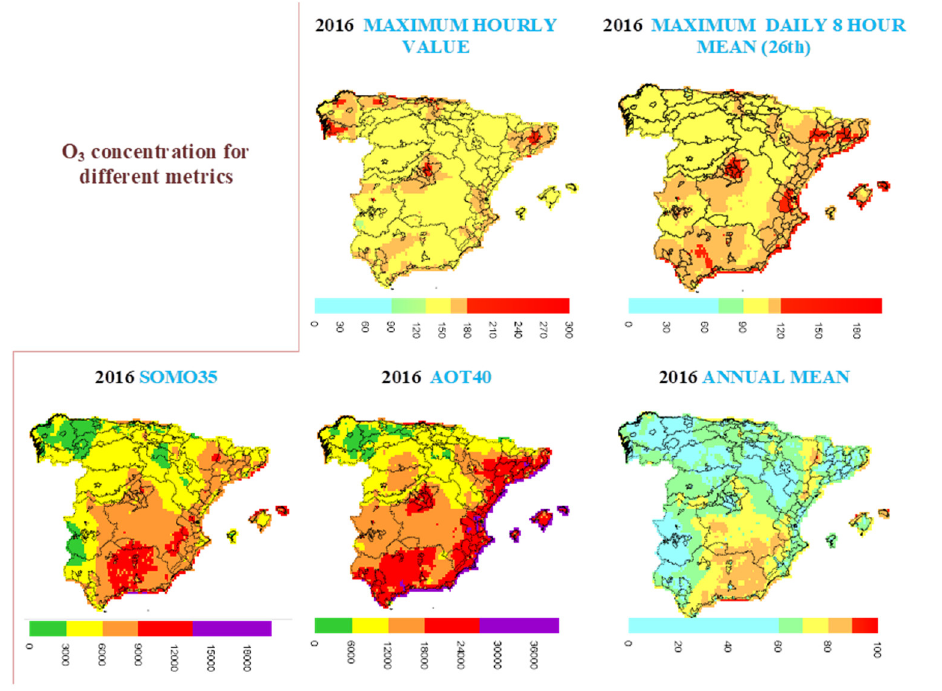
Figure 5. Concentration maps (µg m −3 ) for different ozone metrics, for 2016, estimated by the model approach.